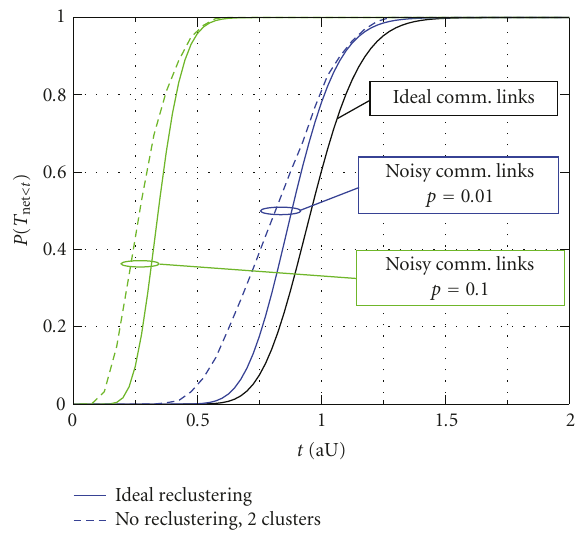
Figure 13: Probability of decision error, as a function of the sen- sor SNR, in a scenario with N = 16 sensors, uniform cluster- ing, and equal a priori probabilities of the common binary phe- nomenon (i.e., p 0 = p 1 = 1 / 2). Communication links are noisy with p = 10 − 2 .